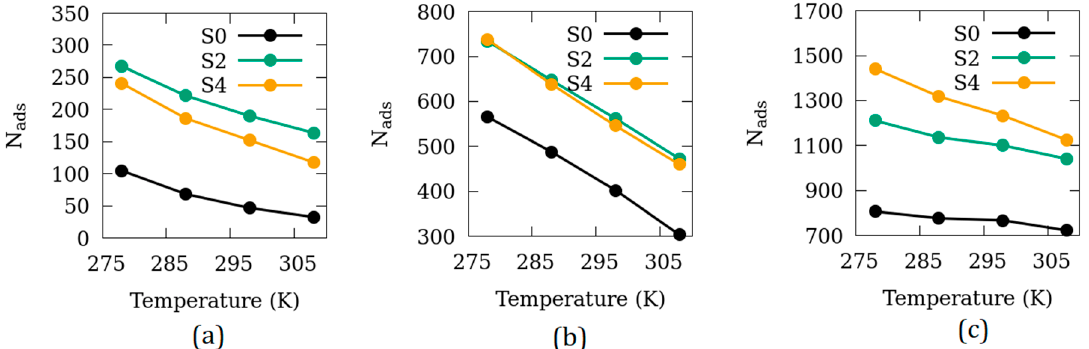
Figure 6. Number of adsorbed CO 2 molecules in the systems S0, S2 and S4 as a function of temperature at ( a ) 0.1 atm; ( b ) 1 atm; ( c ) 10 atm.